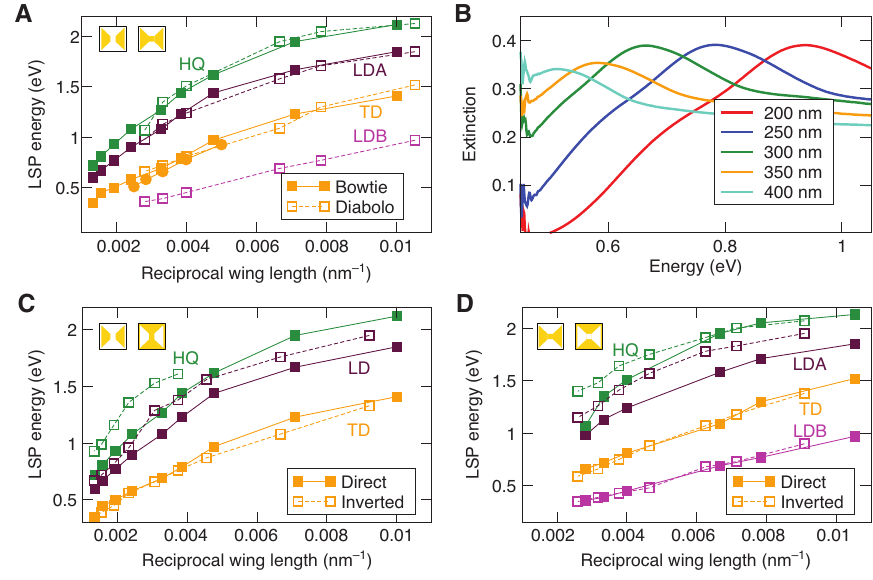
Figure 4: Energy of plasmon modes. (A) Energies of plasmon modes in bowtie (solid lines, full symbols) and diabolo (dashed lines, empty symbols) antennas as functions of the reciprocal wing length L : longitudinal dipolar bonding (LDB) mode (magenta), transverse dipolar (TD) mode (orange), longitudinal dipolar antibonding (LDA) mode (maroon), quadrupolar–hexapolar (HQ) mode (green). Energies retrieved by EELS are shown by squares; energies from optical spectroscopy are shown by circles. (B) Optical transmission spectra of arrays of bowtie antennas for several values of the wing length. (C) Dispersion relation for the bowtie and inverted bowtie: energies of plasmon modes as functions of reciprocal wing length. (D) Dispersion relation for the diabolo and inverted diabolo: energies of plasmon modes as functions of reciprocal wing